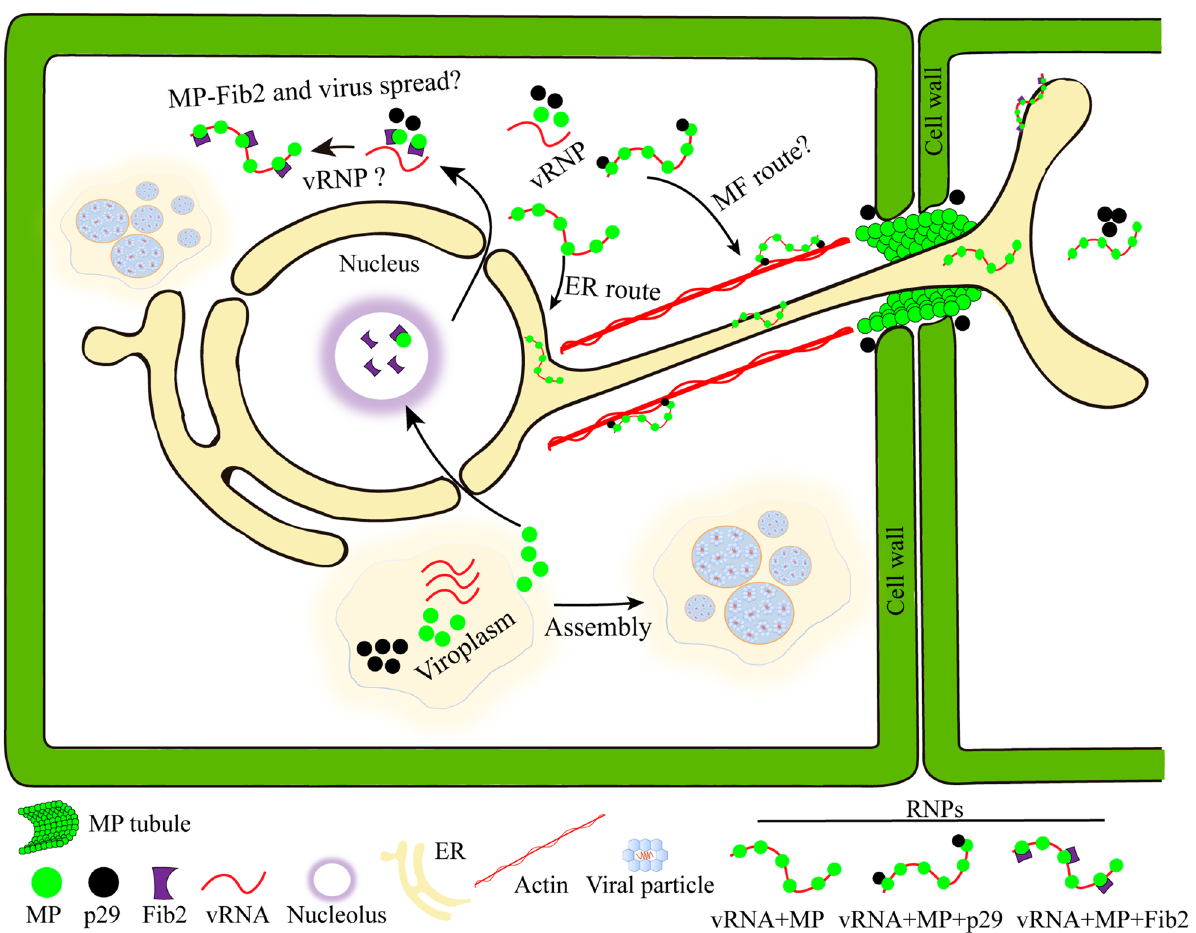
A portion of the MP is transported into the nucleolus of the cell to bind to fibrillarin. The possibility to form a complex between MP plus fibrillarin that could exit the nucleus and interacts with vRNA and/or CP (p29) to form infectious vRNPs, is an open question. The MP, a membrane spanning protein, may anchors the vRNP complex to the ER membrane network, which traffics by the ER system to neighboring cells, facilitating the passage through plasmodesmata by the tubule formation. A possible alternative route may be mediated by the capacity of p29 to interact with MP and to associate with actin, thus anchoring the infectious complexes along the microfilaments (MF), guiding the vRNPs throughout the cytoplasm to the cell periphery. The virus particle is not required for the intercellular transport for this MP (indicating its capability to transport viral complexes different to virus particles intra and intercellularly); furthermore, the MP can transport the infectious complex cell-to-cell and systemically independent of the CP assistance. The redirection of p29 by MP to the plasmodesma could also be implicated to initiate viral replication in the newly infected